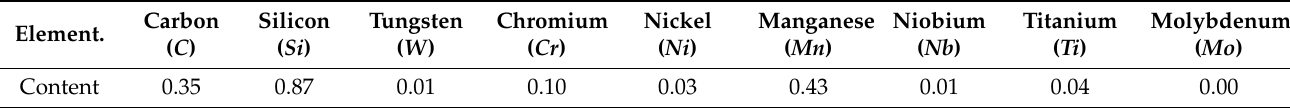
Table 1. Composition of carbon steel.